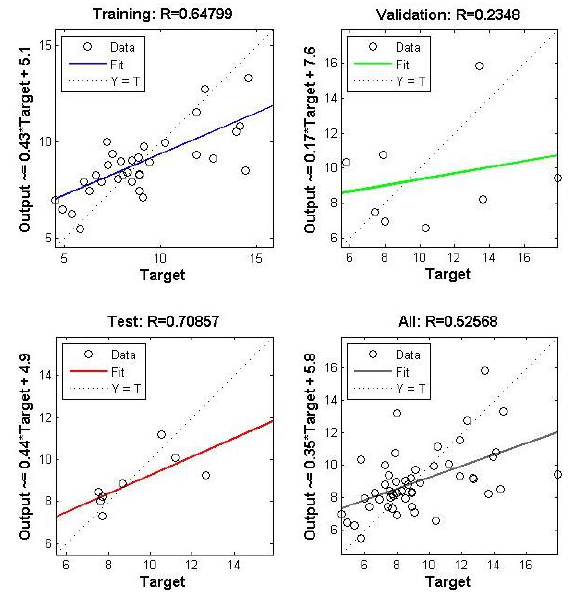
c 2 run 1 PM 2.5 .